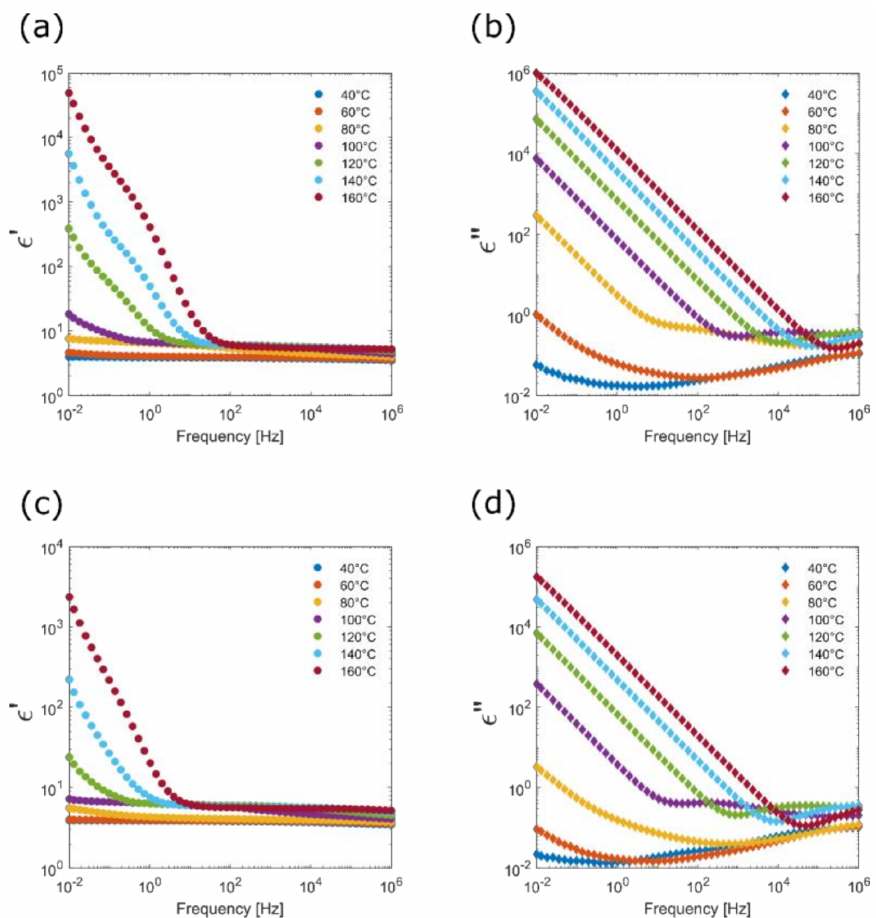
Figure 15. Comparison of the complex permittivities of epoxy-SiO 2 nanocomposite (5 wt.%, pH 11) with APTES:DGEBA mass ratios of ( a , b ) 1:10 and ( c , d ) 1:30. ( a , c ) display the real relative permittivities, while ( b , d ) and display the imaginary